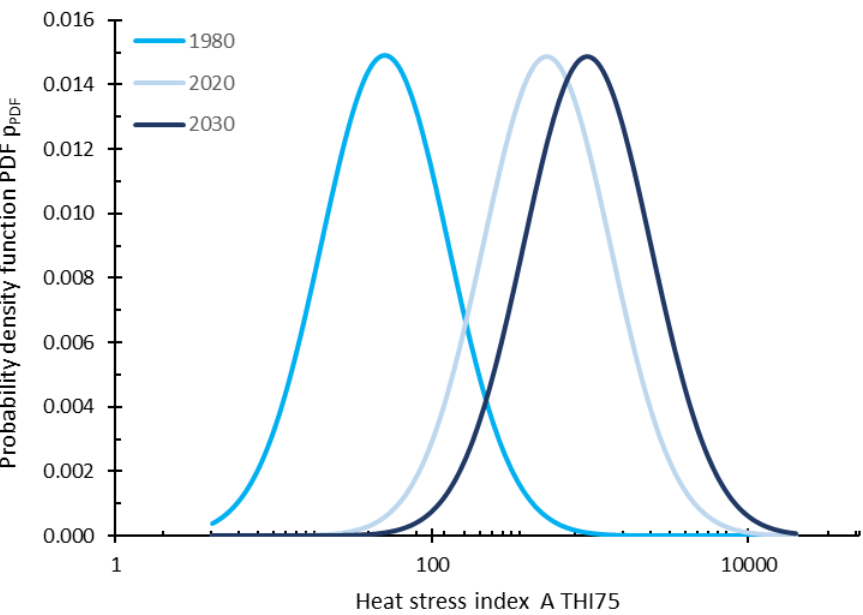
Figure 6. Likelihood of the occurrence of the weather-related heat stress index A THI75 for t = 1980, t = 2020, and t = 2030.